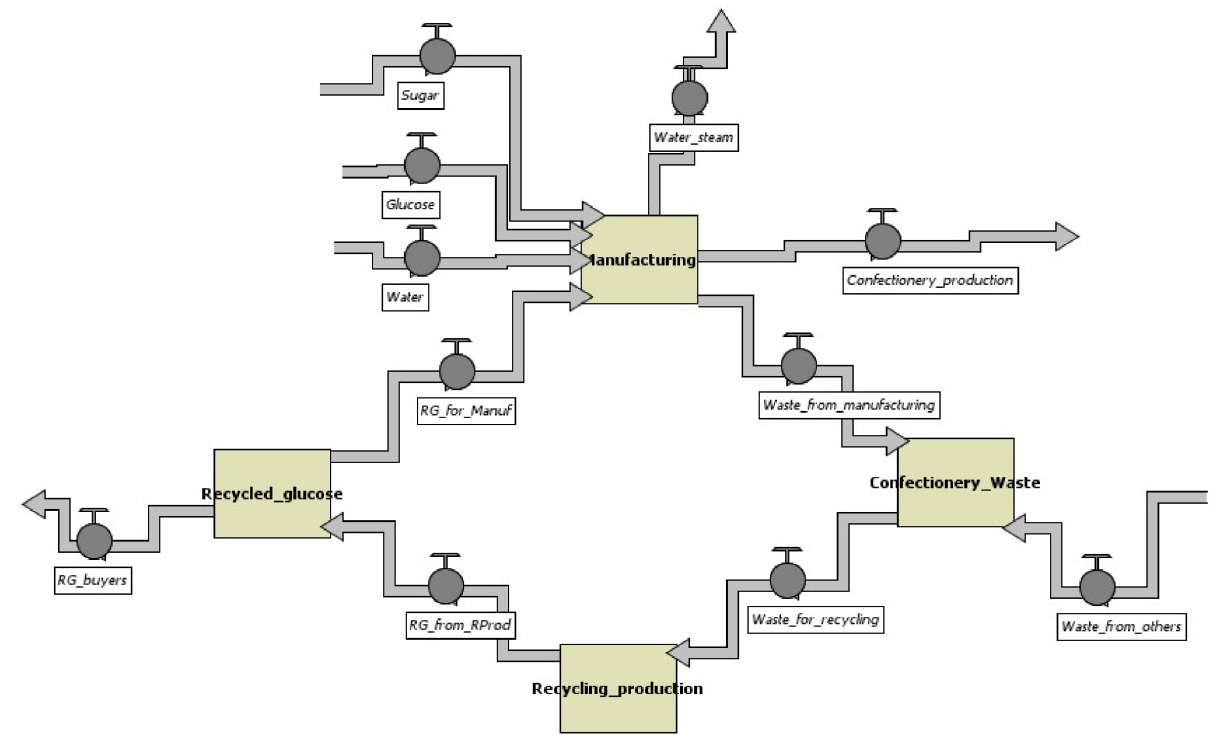
Figure 4. System dynamics model of the confectionery case